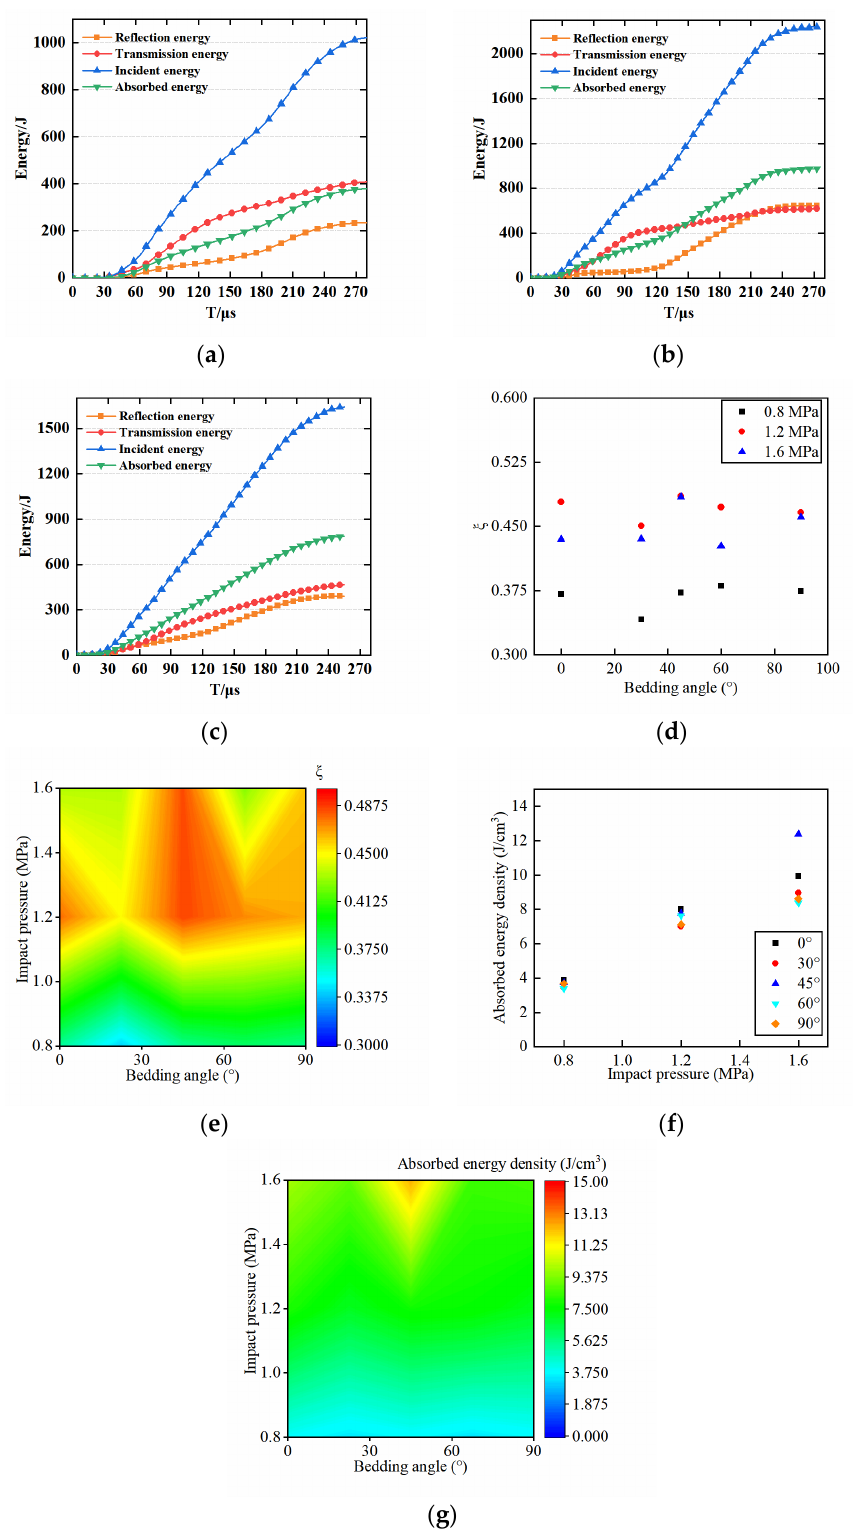
Figure 14. Energy evolution law for samples under different loading conditions. ( a ) P = 0.8 MPa. ( b ) P = 1.2 MPa. ( c ) P = 1.6 MPa. ( d ) Energy utilization. ( e ) Two-dimensional cloud map of energy utilization. ( f ) Absorbed energy density of sandstone. ( g ) Two-dimensional cloud map of absorbed energy density.